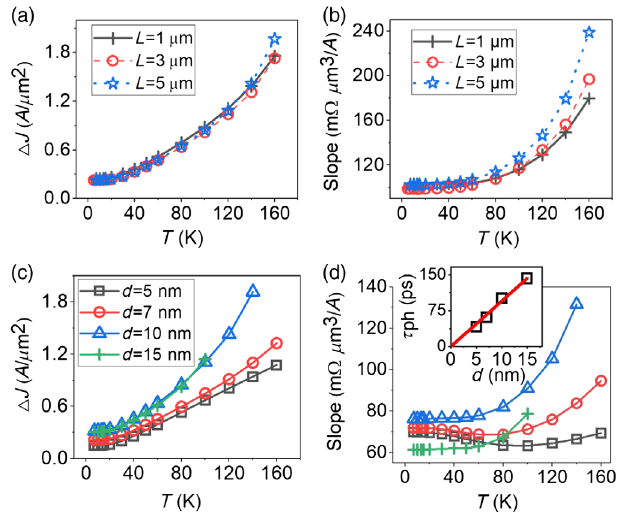
FIG. 3. Effects of the Pt wire geometry. (a),(b) Temperature dependence of the Gaussian broadening width Δ J (a) and the linear slope (b) of ρ ð J Þ , for 10-nm-thick Pt wires with lengths L ¼ 1 , 3, and 5 μ m, as labeled. (c),(d) Same as (a),(b), for 1 - μ m- long Pt wires with thicknesses d ¼ 5 , 7, 10, and 15 nm, as labeled in (c). Inset in (d): Dependence of the phonon relaxation time τ on the Pt thickness, determined from the data at T ¼ 5 K using Eq. (6) (symbols), and linear fit with zero intercept